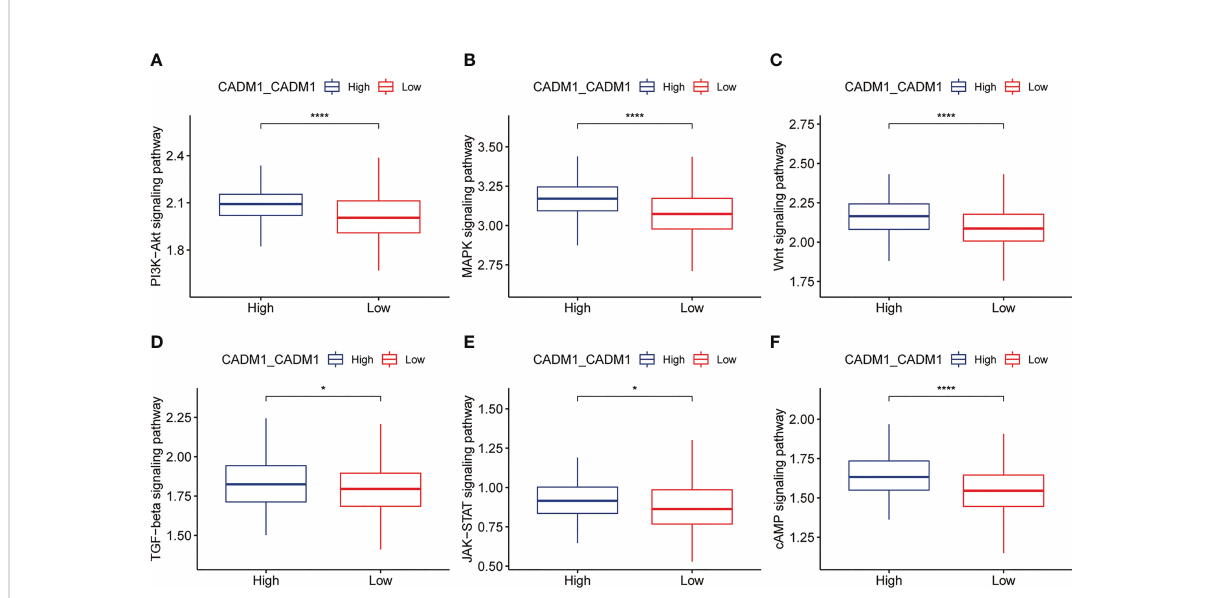
FIGURE 6 Box plots showing ssGSEA scores of related signaling pathways in high and low expression groups of CADM1-CADM1 (****P < 0.0001, *P < 0.05). (A) PI3K-Akt signaling pathway. (B) MAPK signaling pathway. (C) Wnt signaling pathway. (D) TGF- b signaling pathway. (E) JAK-STAT signaling pathway. (F) cAMP signaling